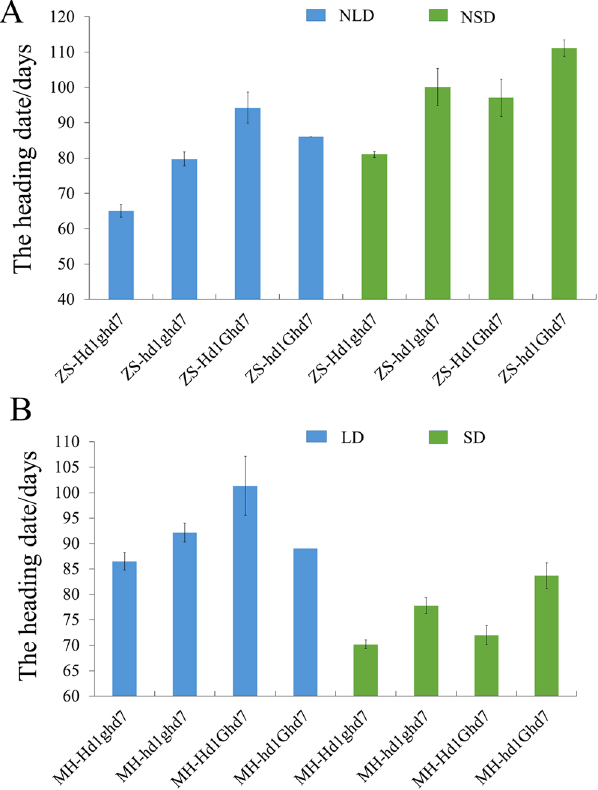
Figure 4. Genetic interaction on heading date between Ghd7 and Hd1 under long day and short day conditions. The heading date of 4 homozygous combinations between Ghd7 and Hd1 in Zhenshan 97 background ( A ) and Minghui 63 background ( B ). “NLD”, nature long days in Wuhan, Hubei; “NSD”, nature short days in Lingshui, Hainan. “LD”, controlled long day-length of 14 hours light; “SD”, controlled short day-length of 8 hours